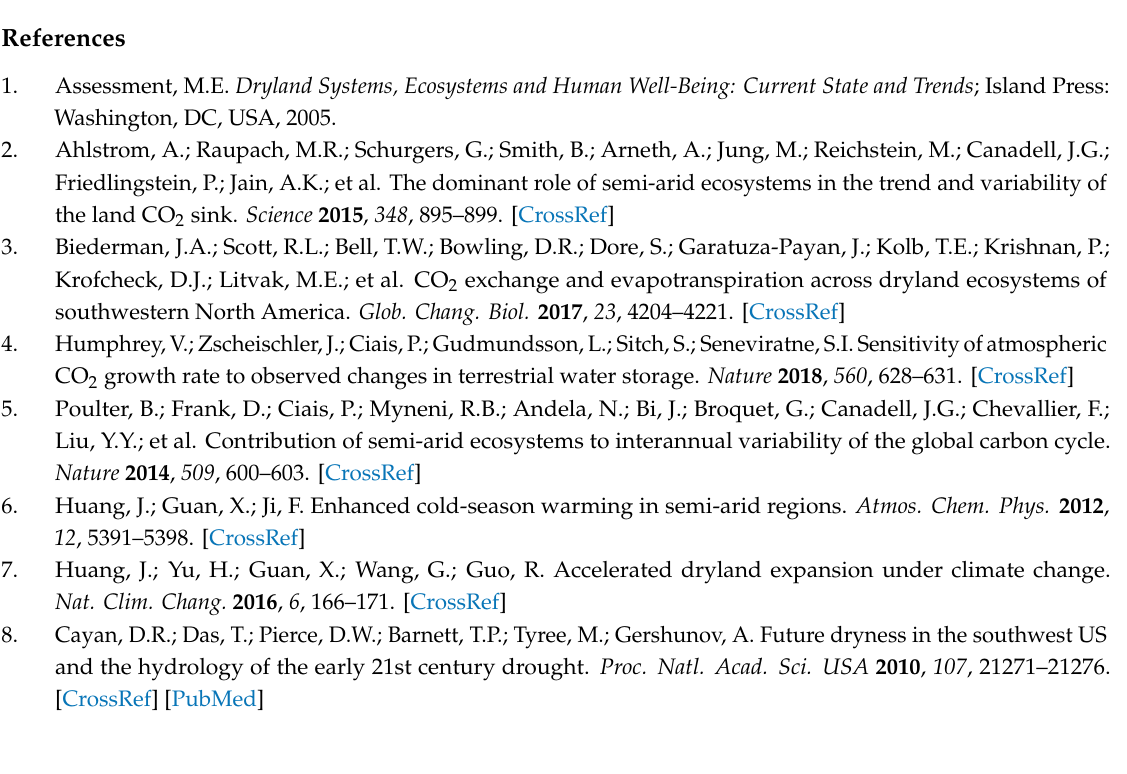
Table S1: Selected Variables for the Data-driven Machine Learning Modelling, Table S2: The metrics of selected models for SSM and